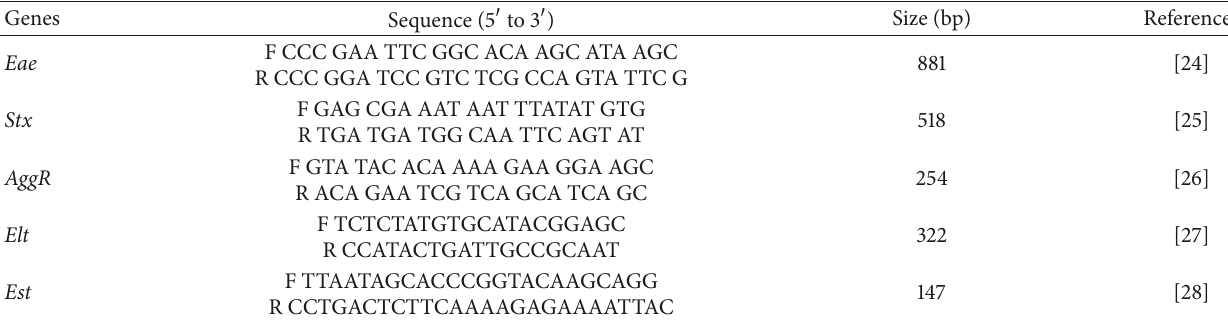
Table 1: Primers used for PCR in this study